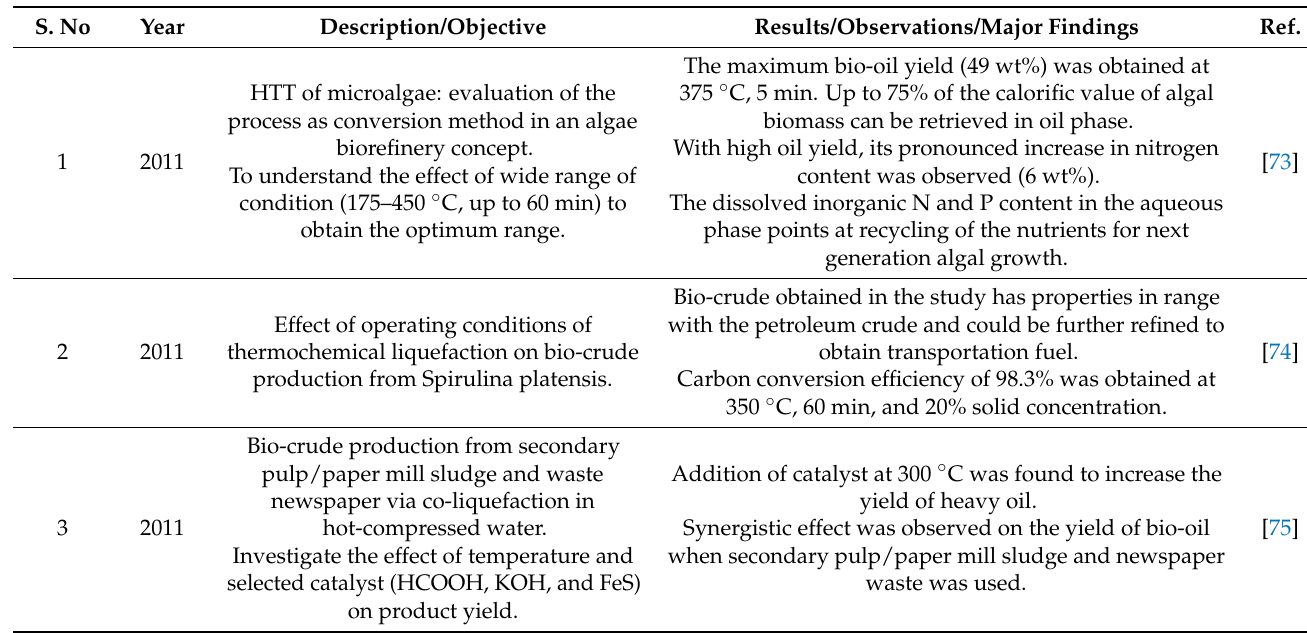
Table 2. Some major studies on the effects of temperature, pressure, retention time, feed ratio, and heating rate. S.